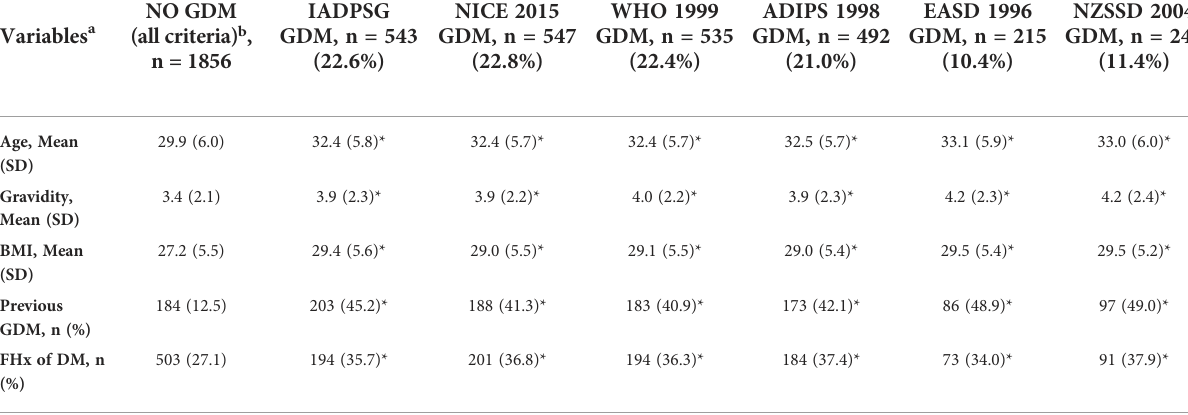
TABLE 4 Risk factors distribution according to the GDM status (comparison is with no GDM by all criteria).